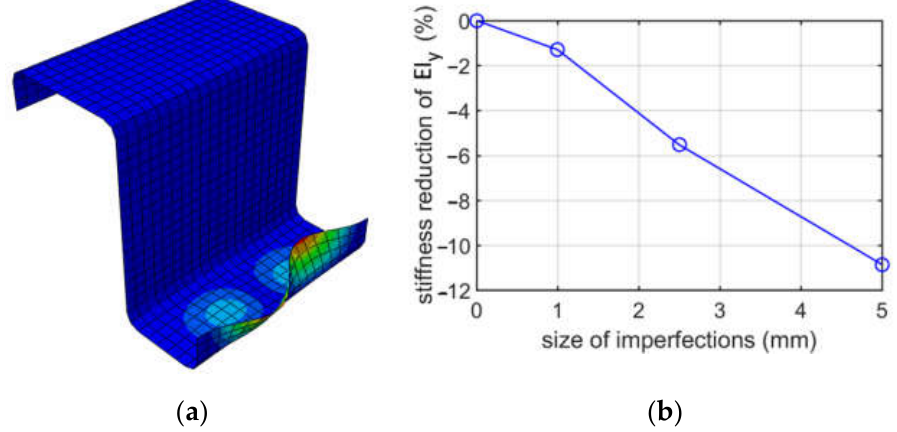
Figure 10. Buckling due to bending about the vertical axis for case (ii), for a depth of 100 mm: ( a ) mode 1; ( b ) plot of the stiffness reduction of EI y , depending on the size of imperfections. Table 6. Stiffness reduction of the Z profile with elongation of 100 mm due to bending about the vertical axis for (ii) case, depending on the size of imperfections.